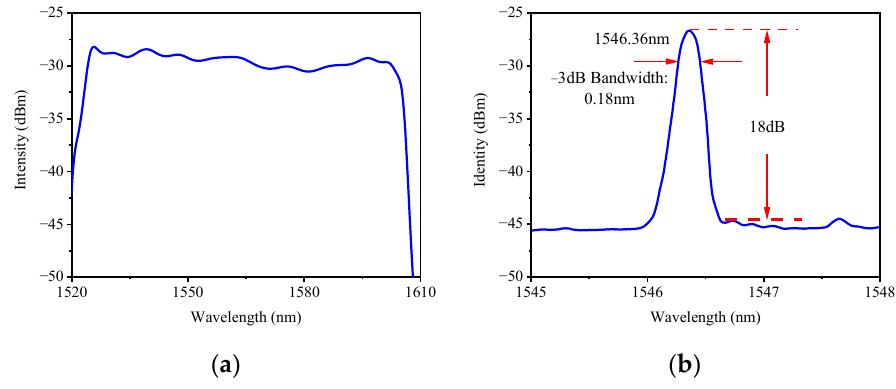
shown in Figure 5. The light source is relatively flat, in the 1520–1610 nm range. The FBG used in this paper has a center wavelength of 1546.432 nm, a −3 dB bandwidth of 0.18 nm, this paper has a center wavelength of 1546.432 nm, a − 3 dB bandwidth of 0.18 nm, and an and an FBG length of 10 mm. FBG length of 10 mm.